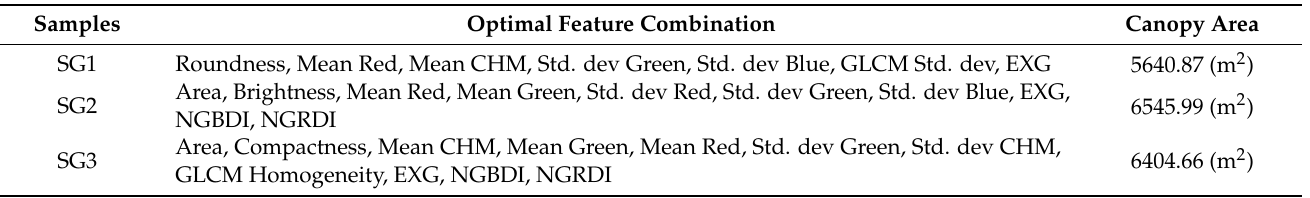
Table 5. An optimal combination of features for surface samples outside the Shenxiantang